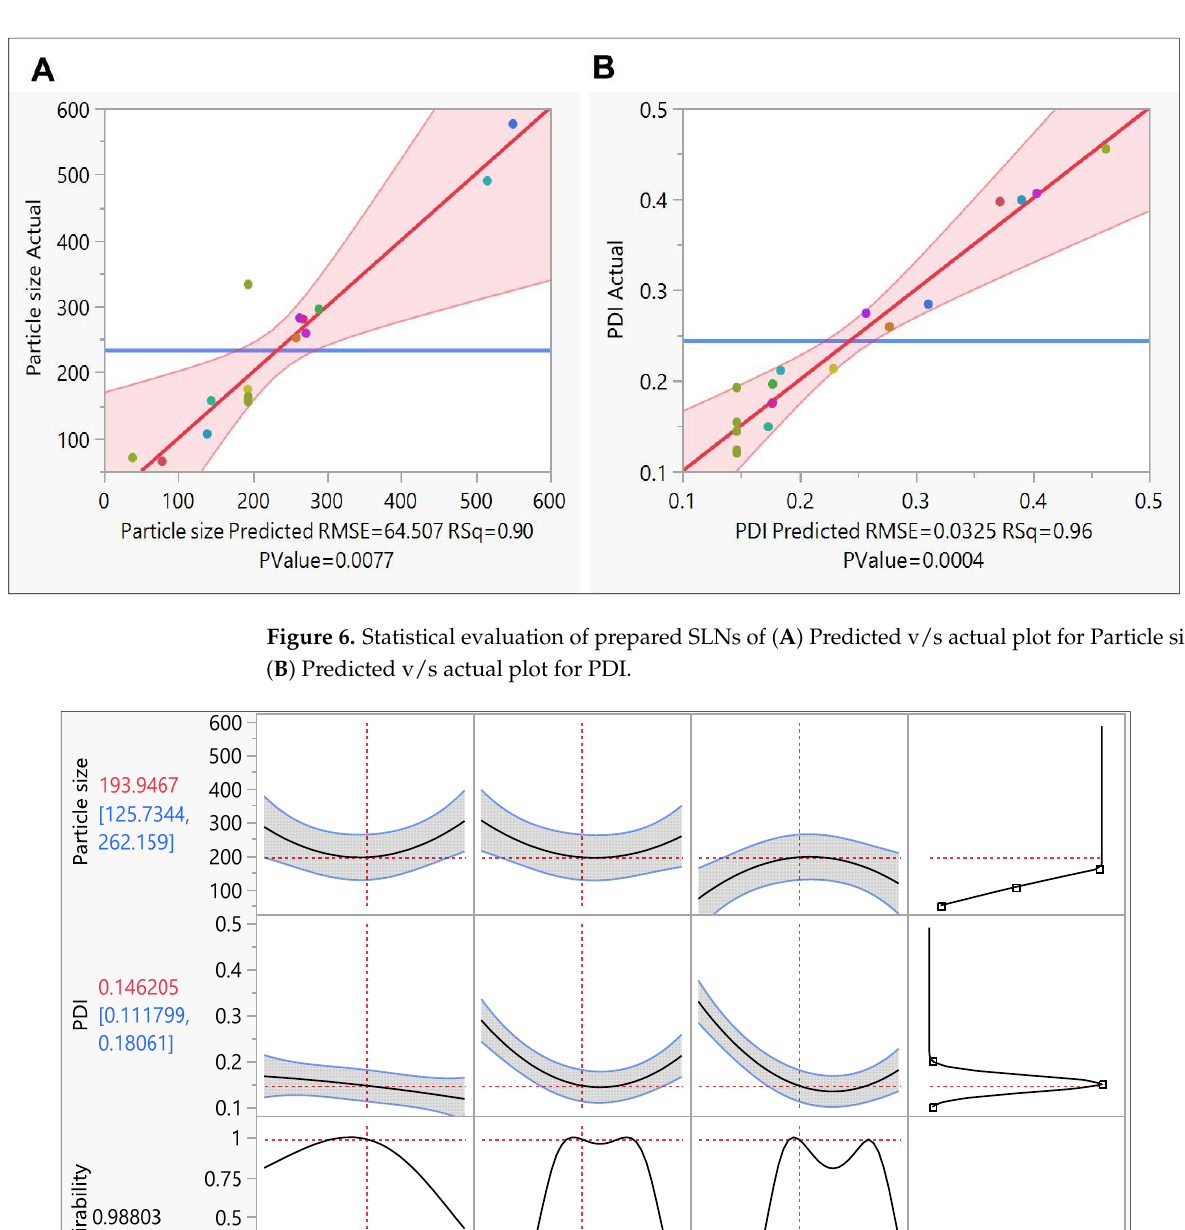
Figure 6. Statistical evaluation of prepared SLNs of ( A ) Predicted v/s actual plot for Particle size and ( B ) Predicted v/s actual plot for PDI.